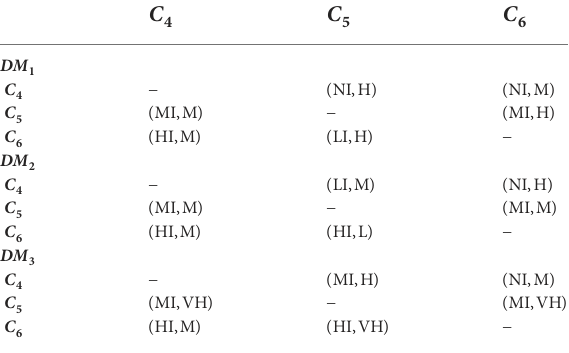
TABLE 8 Pair influence degree of the sub-criteria of Q 2 for three decision